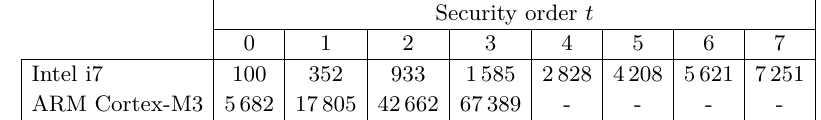
Table 12: Saber.Decaps cycles counts on Intel(R) Core(TM) i7-1065G7, in thousands of